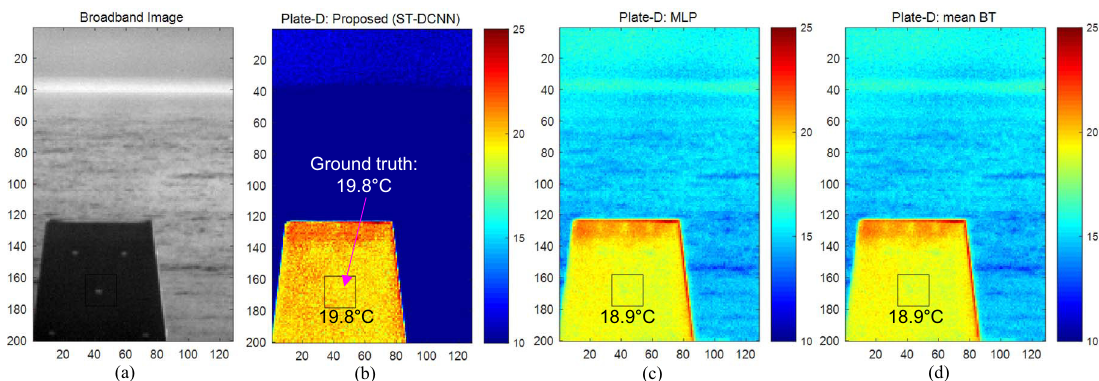
Figure 14. Visualized comparison of temperature estimation: ( a ) broadband image; ( b ) proposed